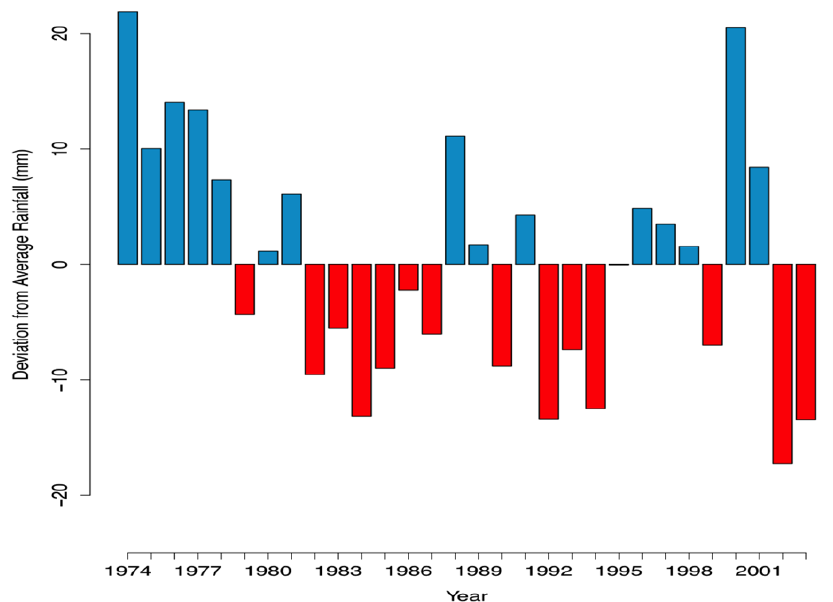
Figure 3. Annual rainfall patterns in Botswana from 1974–2003 reflect high variability between years and the occurrence of drought (red) and wet cycles